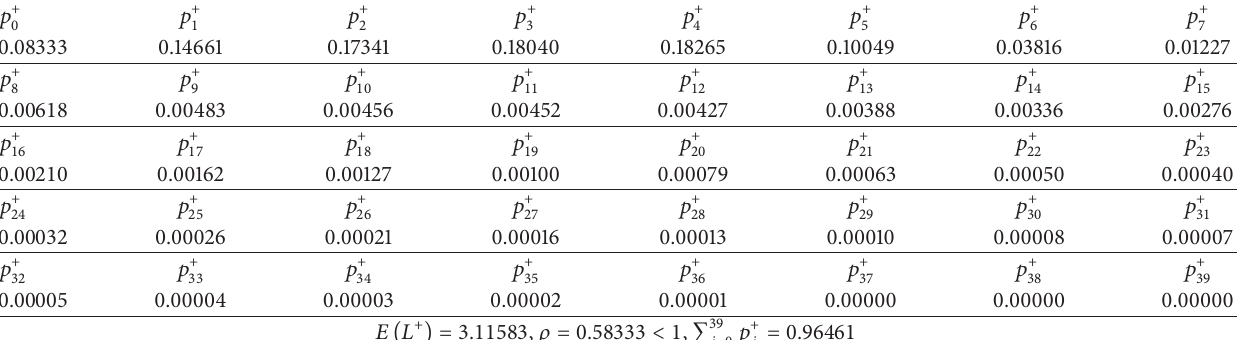
Table 1: The steady-state service request number distribution for a network access proxy system ( 𝑝 = 0.15 , 𝜇 = 2 , 𝜃 = 0.9 , 𝛼 = 0.01 , 𝛽 = 5 , and 𝑁 = 5 ).